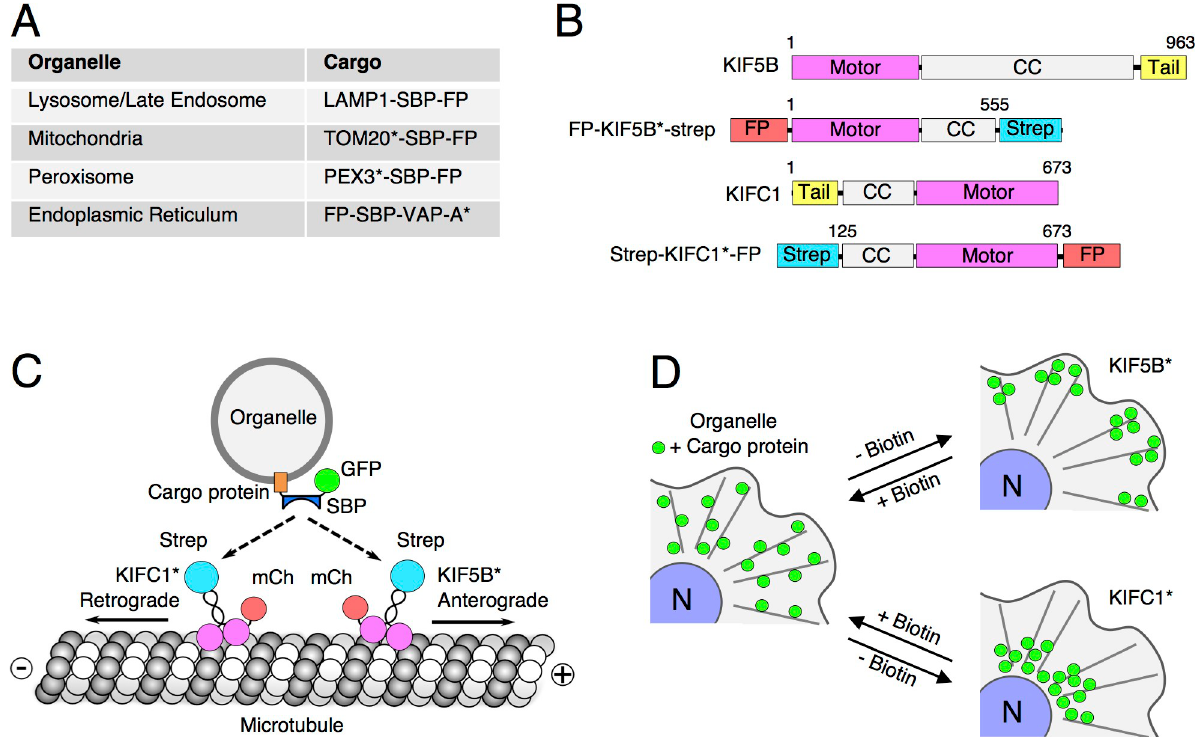
Fig 1. Schematics of RAMP. (A) RAMP cargo constructs used in this study. (B) RAMP motor constructs used in this study. Amino-acid numbers are indicated. Tail is the natural cargo-binding domain. In some experiments, the FP was replaced by a HA epitope. Additional motor constructs are shown in S8B Fig. The asterisks indicate that only fragments of the cargo and motor proteins were used to make the constructs (for more details, see Methods section). (C) Coexpression of the RAMP cargo and motor constructs results in coupling of the organelle to the motor, with consequent motor activation and organelle redistribution in anterograde (KIF5B � -based construct) or retrograde (KIFC1 � -based construct) direction. (D) Representation of the redistribution of organelles upon expression of RAMP constructs. Addition of biotin outcompetes the SBP–streptavidin interaction, reversing the peripheral or perinuclear accumulation of the organelle. CC, coiled coil; FP, fluorescent protein; GFP, green fluorescent protein; HA, hemagglutinin; KIF, kinesin superfamily; LAMP, lysosome-associated membrane protein; mCh, mCherry; PEX, peroxin; RAMP, reversible association with motor proteins; SBP, streptavidin-binding protein; Strep, streptavidin; TOM, translocase of the outer membrane; VAP, VAMP-associated protein.